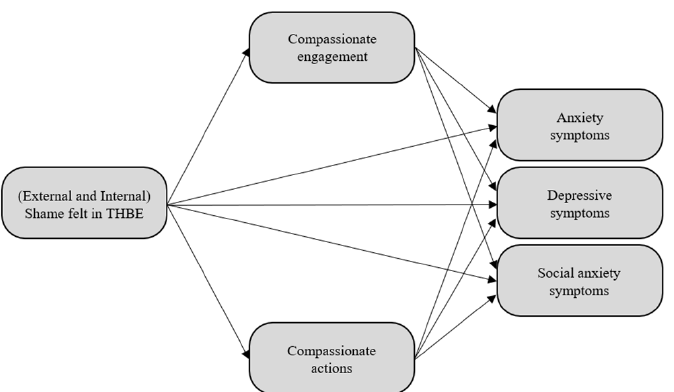
Figure 1. The proposed model in which both internal and external shame felt in traumatic homophobic bullying experience indirectly predict mental health indicators (anxiety, depression, and social anxiety symptoms) through both compassionate engagement and actions.